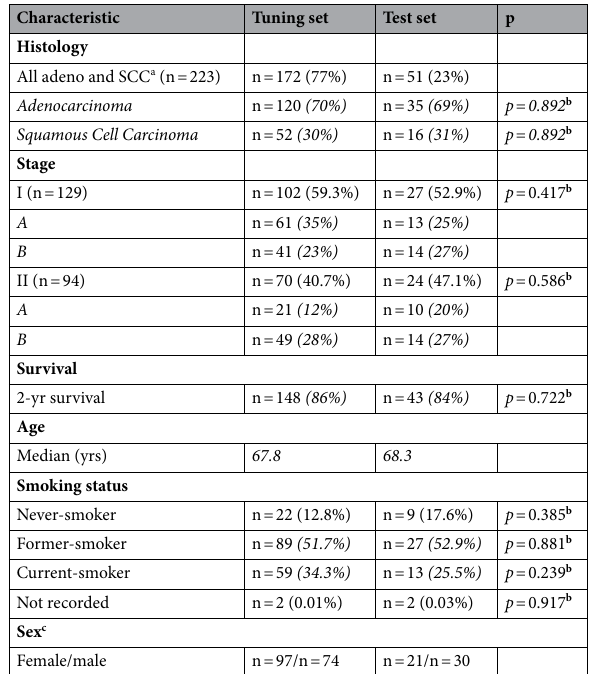
Table 2. Tuning and test dataset characteristics. Data presented as n, % of respective data set (tuning or test). a Total number of cases with either adenocarcinoma or squamous cell histology, n. b p represents the significance of the difference between the two sets. c Sex not recorded in one case